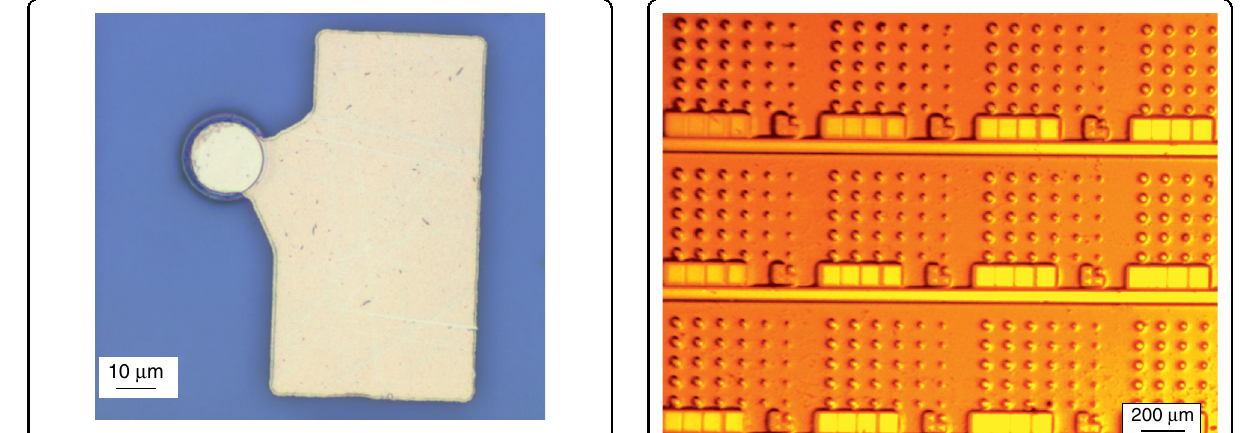
Fig. 3 Planarization of microlaser. Planarized QWD-on-GaAs microdisk with contact pad placed aside